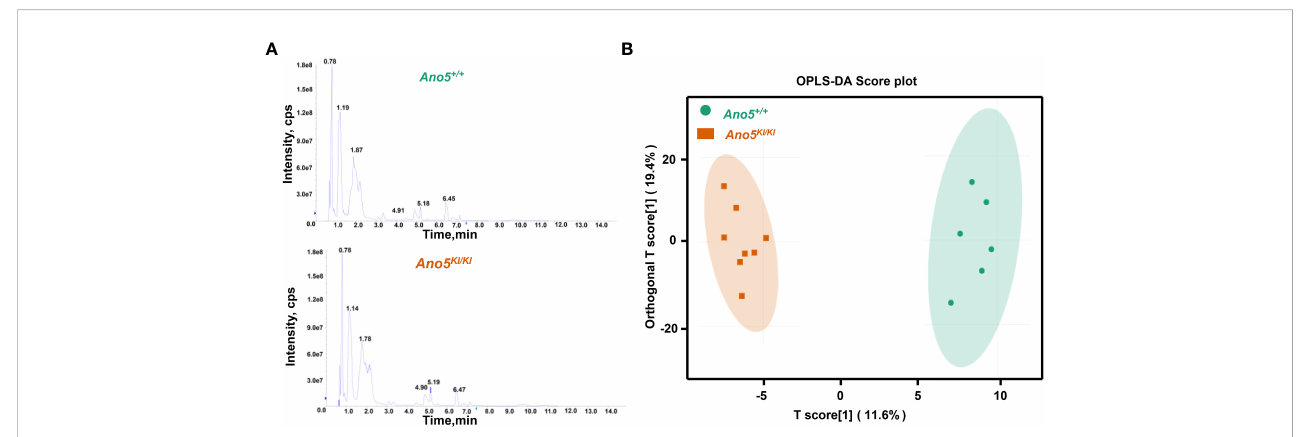
FIGURE 1 Multivariate statistical analysis of metabolite pro fi les. (A) Total ion current (TIC) diagram of Ano5 +/+ (upper panel) and Ano5 KI/KI (lower panel) mCOBs. The X-axis indicating retention time (Rt, min) for metabolite detection and the Y-axis representing ion fl ow intensity (CPS, count per second); (B) OPLS-DA multivariate statistical analysis. Separation of the Ano5 +/+ and Ano5 KI/KI groups occurs in the horizontal (T1) direction, while the vertical (orthogonal T1) axis re fl ects intra-group